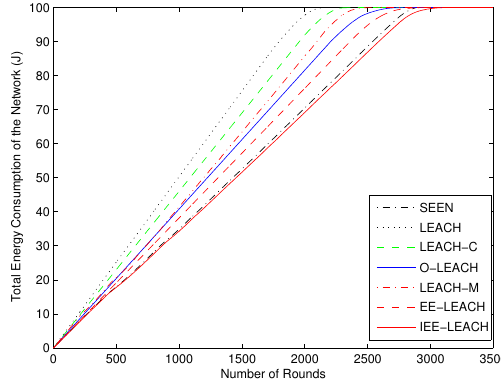
Figure 11. Comparison of total energy consumption of the network.